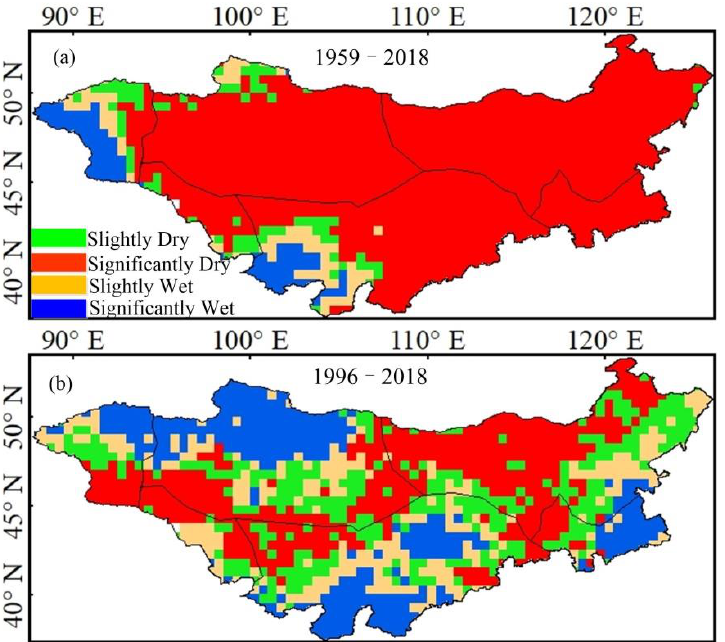
Figure 10. Spatial trend of drought in the MP based on ( a ) Sen’s slope and the ( b ) MK trend test.